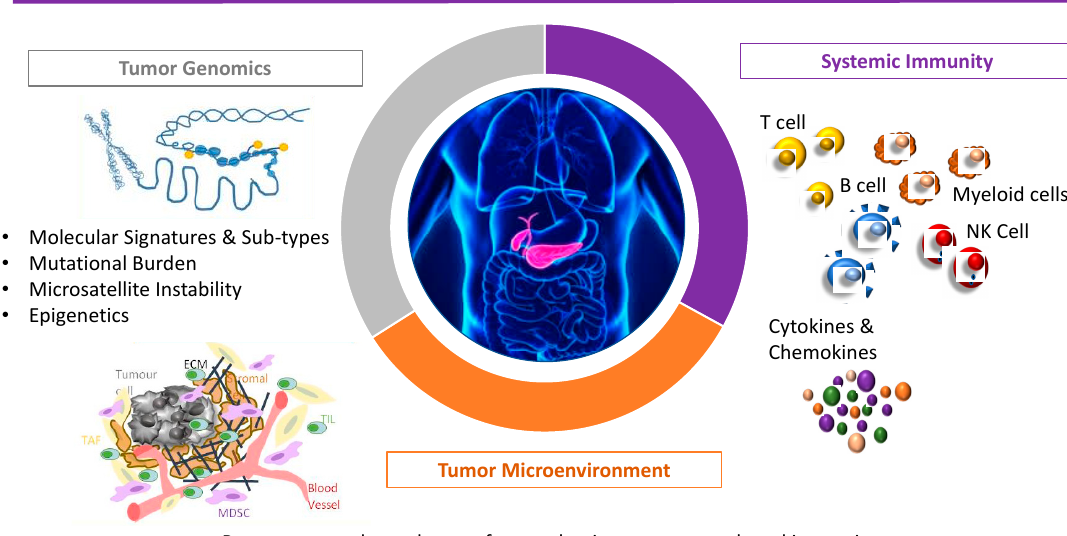
Figure 1. Understanding systemic immunity in the context of the tumor microenvironment and immune-privilege in pancreatic cancer.